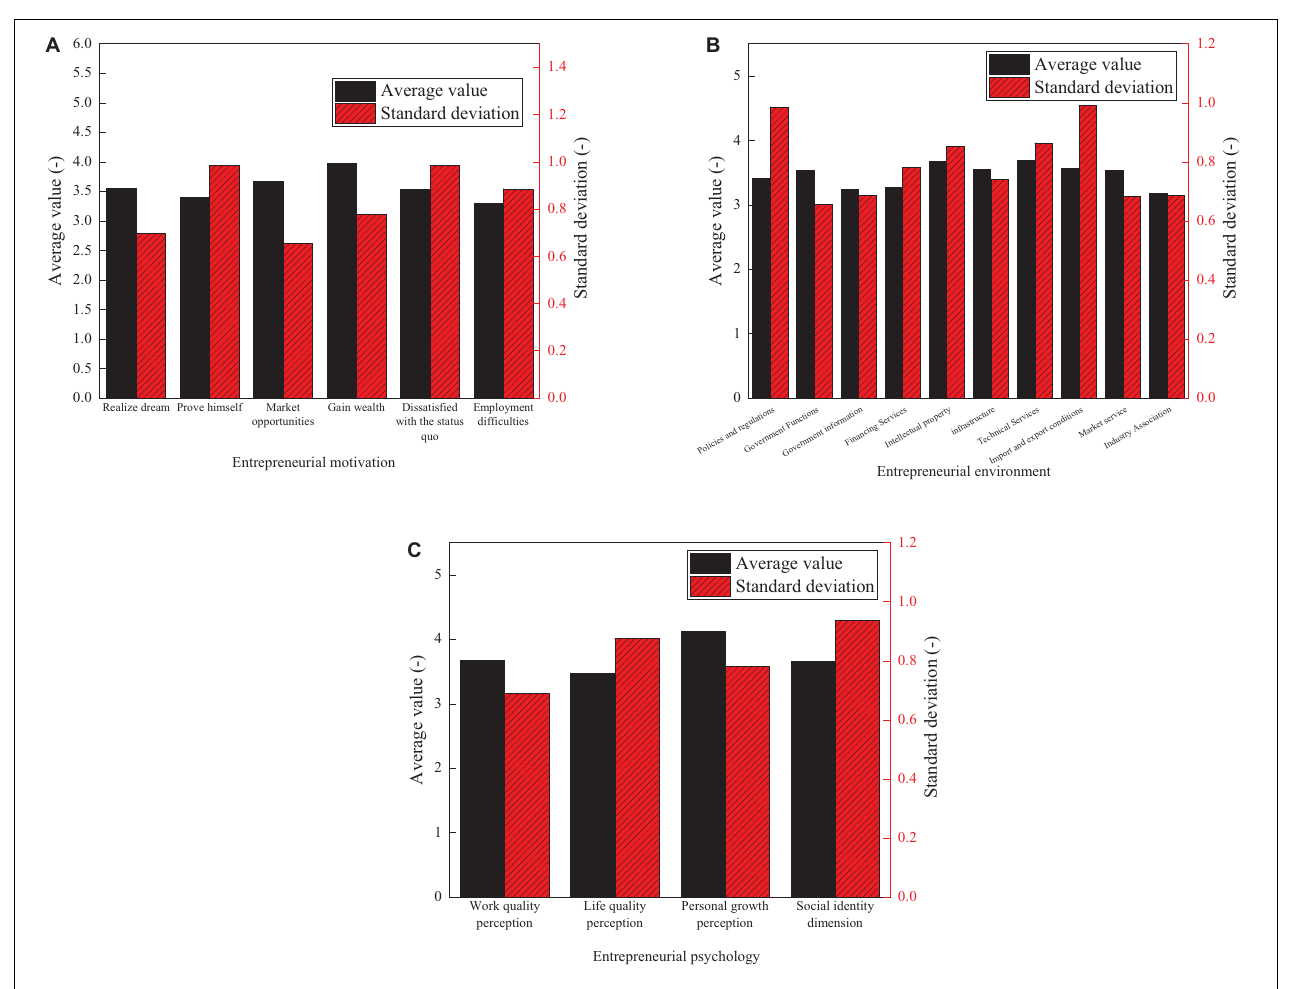
FIGURE 3 | Scores of questionnaire survey results. (A–C) represent the entrepreneurship motivation scale, entrepreneurship environment scale and entrepreneurship psychology scale